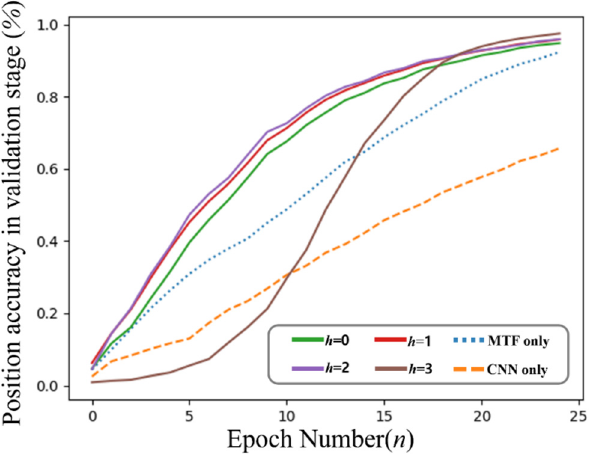
Figure 11. Results of the three worst positions among the 150 cells with highest distance errors in cells (11, 0) on the left, (8, 8) in the middle, and (3, 8) on the right of the figure.